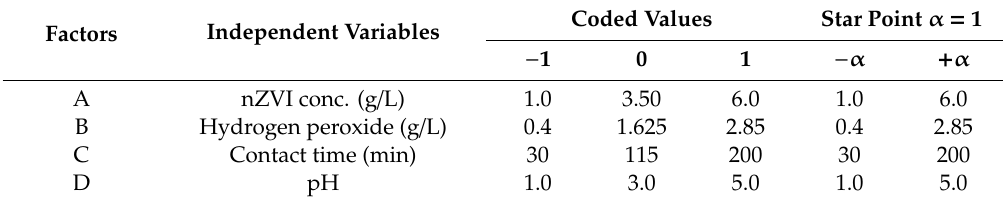
Table 1. Actual and coded values for experimental design for the Fenton